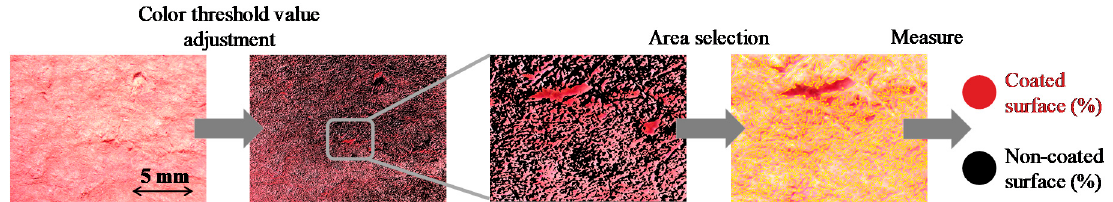
Figure 4. Surface coverage estimation process by the evaluation of the optical microscope images step by step using ImageJ software.